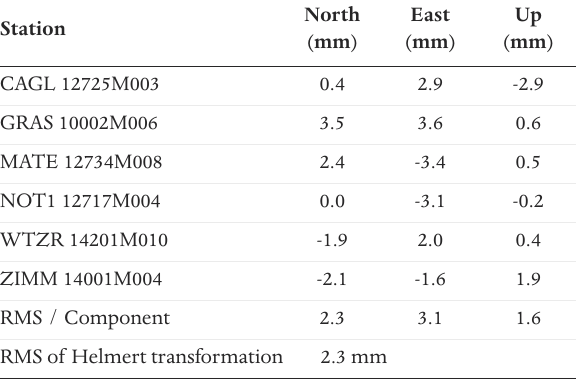
Table 2. Residuals from Helmert transformation between IGS08 and solution for the reference stations.